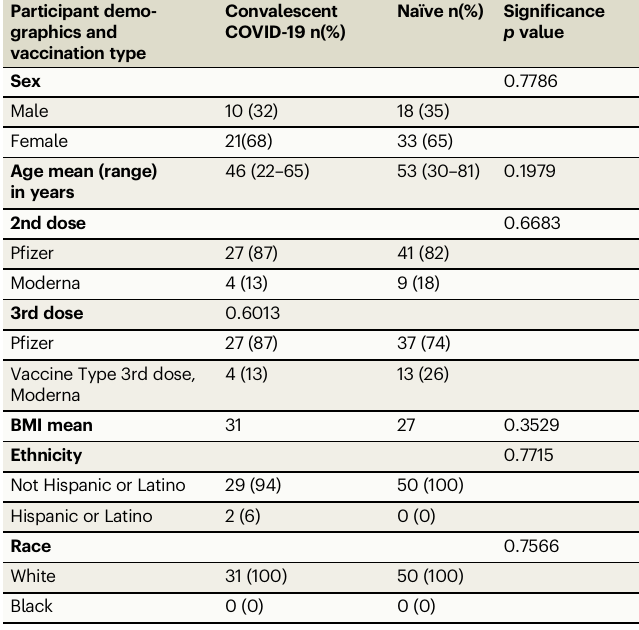
Table 1 | Participant demographics and